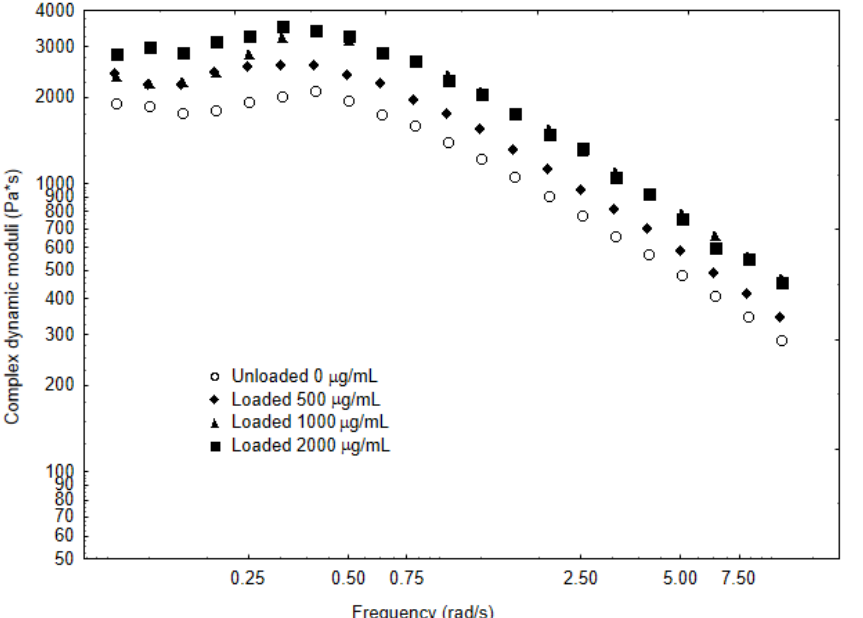
Figure 2. Rheological behavior of complex moduli of the unloaded and loaded bigels with aqueous extract of Quercus leaves.